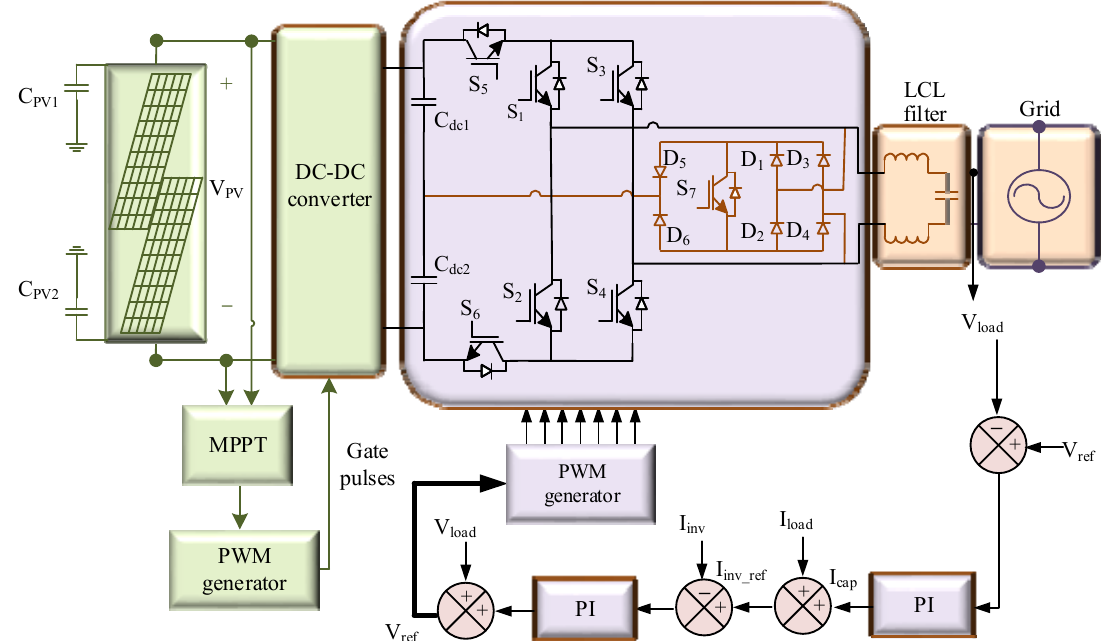
Figure 5. Control strategy for the proposed transformer-less inverter.